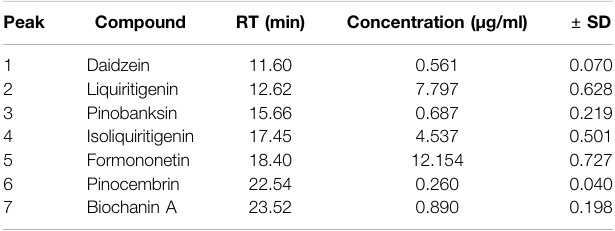
TABLE 3 | Quanti fi cation of some chemical compound in EABRP by UPLC-DAD.